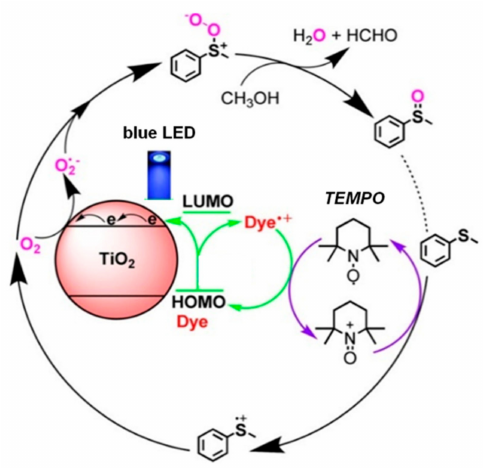
Figure 4. Proposed mechanism for the visible-light-induced selective oxidation of sulfide into sulfoxide with air on alizarin red S (ARS)-sensitized TiO 2 with TEMPO ((2,2,6,6-tetramethylpiperidin-1-yl)oxyl) as a redox mediator. Adapted and reprinted with permission from [49], Copyright (2018) Wiley.